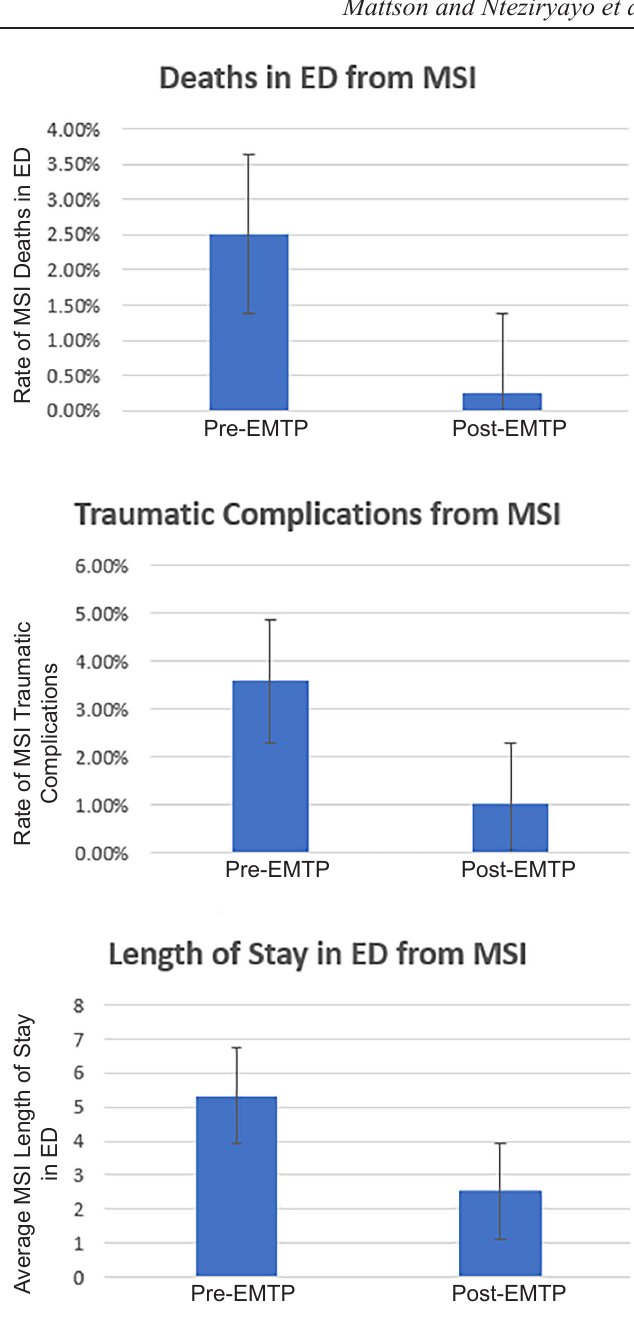
Figure 1. EM residency outcomes among MSI patients with musculoskeletal injuries show decreased death rate, complication rate, and duration of stay in emergency department. Using two- sample t-tests with equal variance for patients treated before vs after implementation of EMTP, results demonstrate a decrease and thus improvement in the three primary outcomes of interest. EMTP reduced the death rate in the ED from MSI by 89.9%, from 2.51% to .253% (p=0.0077). The program dropped traumatic complications from MSI by 71.7%, from 3.58% to 1.01% (p = .0211). Lastly, EMTP reduced duration of stay in the ED by 52.7% or 2.81 days on average, from 5.33 to 2.52 days (p =